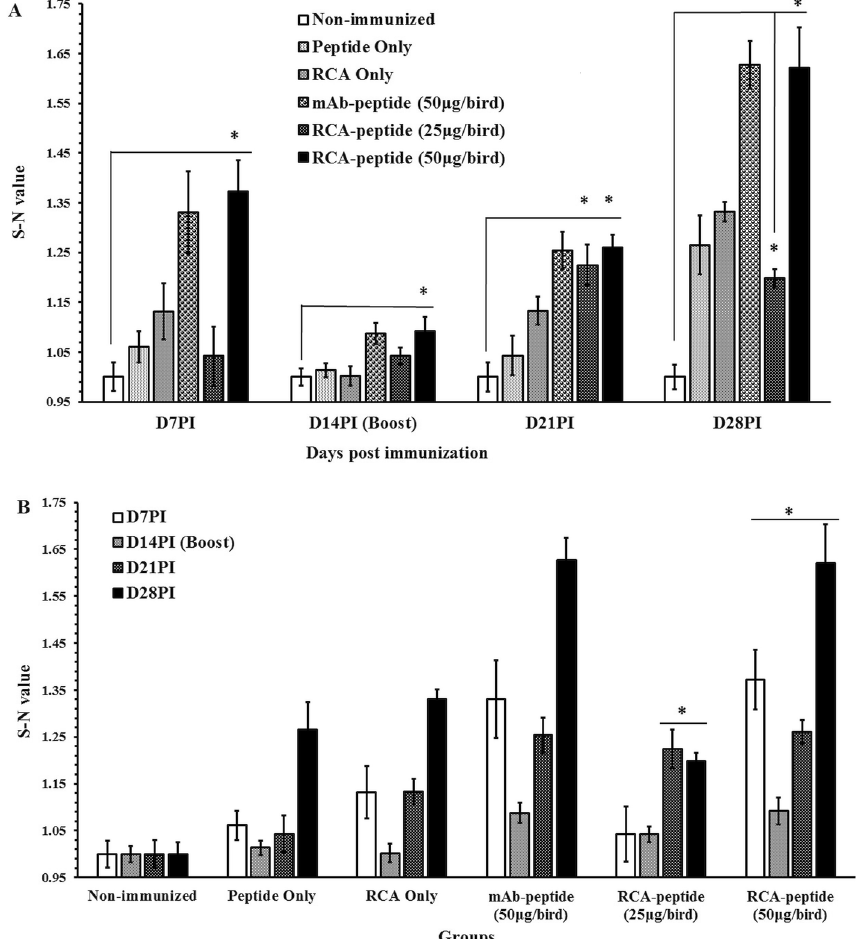
Figure 5. Normalized ELISA results representing S–N values of the anti-M2e IgG in chicken sera at weekly intervals after immunization. Birds (n = 20) were immunized at day 7 and day 21 via s/c route with (1) None (negative control), (2) M2e peptide, (3) aptamer RCA II, (4) mAb-SA-M2e, (5) aptamer RCA II-SA-M2e complex at 25 μg/bird or 50 μg/bird. The normalization calculations S–N = (any read—mean reads of the non- immunized group). The mean of each group calculated accordingly. Results show mean ± SE and the differences are according to ANOVA and student t -test. Asterisks represent statistical differences (* p = 0.0001) from the non-immunized